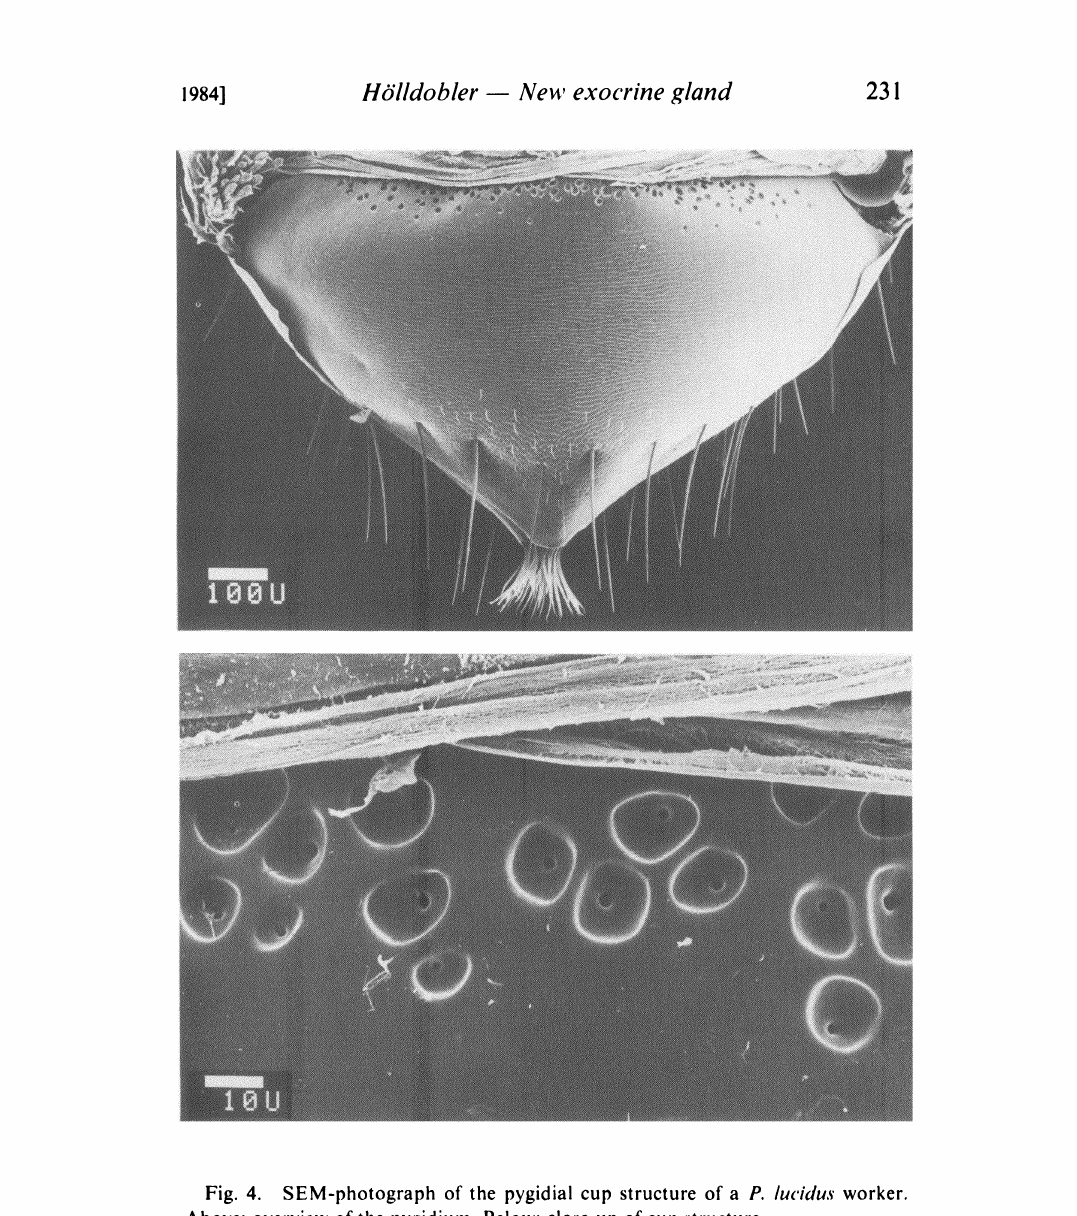
Fig. 4. SEM-photograph of the pygidial cup structure of a P. lucidus worker. Above: overview of the pygidium. Below: close-up of cup